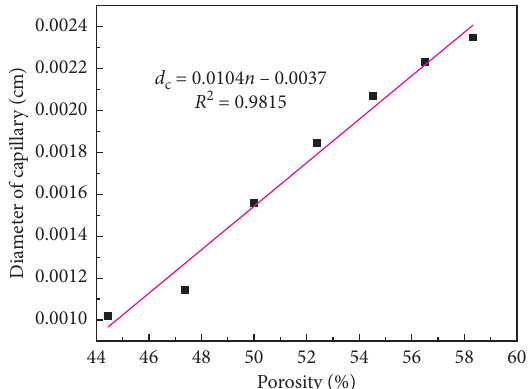
Figure 7: Relationship between the diameter of capillary and porosity.